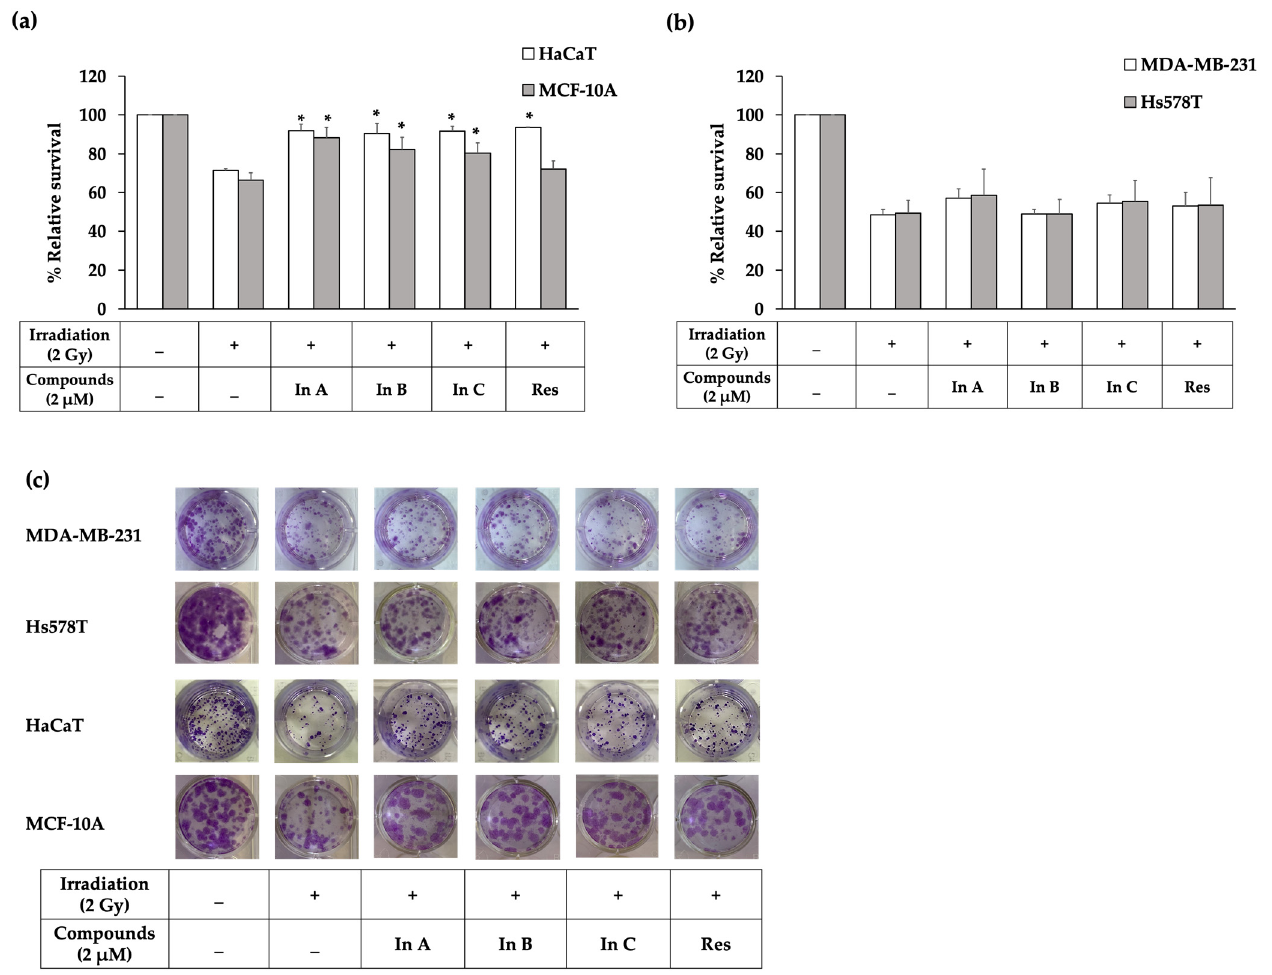
Figure 3. ( a ) Relative survival in the clonogenic cell survival assay after treatment with In A (interruptin A), In B (interruptin B), In C (interruptin C), and Res (resveratrol) in HaCaT and MCF-10A normal cells. Data represent the mean ± SD values from three independent experiments. The significance of the mean differences was analyzed using Kruskal–Wallis with Dunn’s test. * p < 0.05 compared to the irradiation-alone group. ( b ) Relative survival in the clonogenic cell survival assay after treatment with In A, In B, In C, and Res in HaCaT and MCF-10A normal cells. Data represent the mean ± SD values from three independent experiments. The significance of the mean differences was analyzed using Kruskal–Wallis with Dunn’s test. * p < 0.05 compared to the irradiation-alone group. ( c ) Images from the clonogenic cell survival assay after treatment with In A, In B, In C, and Res in MDA-MB-231 and Hs578T breast cancer cells and HaCaT keratinocyte and MCF-10A normal breast cells.